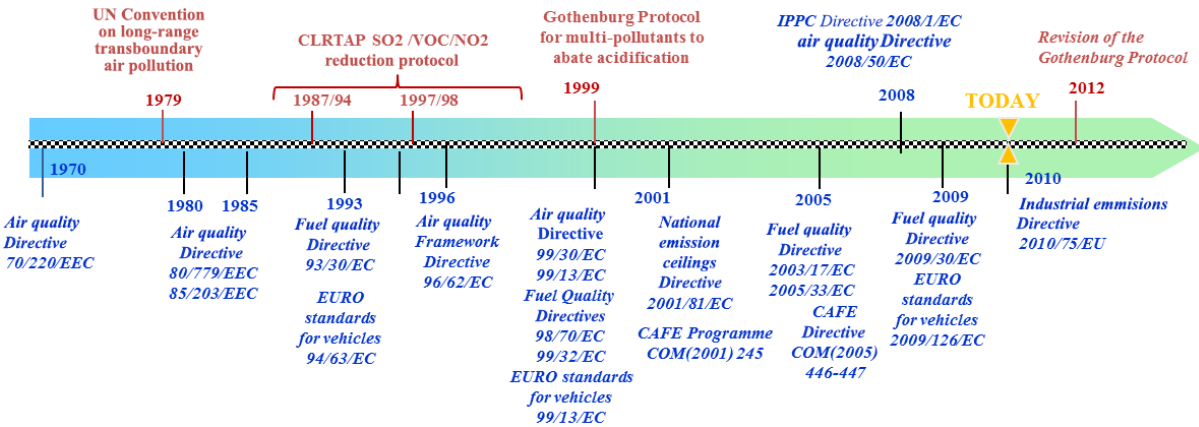
Figure 1. Overview of historical European Union (in blue) and international (in red) air quality regulations. UNECE/CLTRAP covers all European countries, USA, Canada, Belarus, Russia, Turkey, Israel, Ukraine, and central Asian